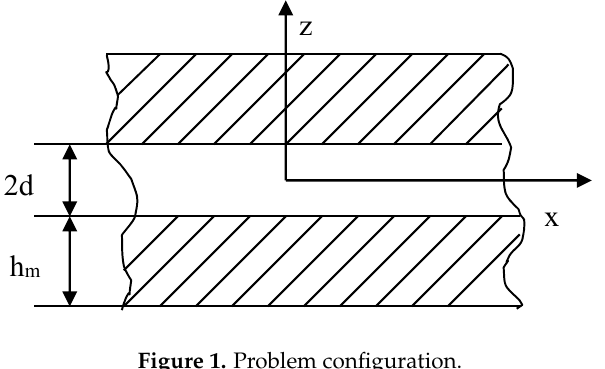
Figure 1. Problem Figure 1. Problem configuration.